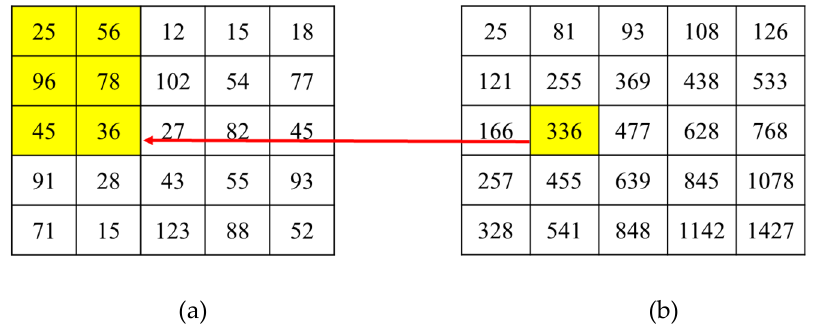
Figure 4. Steps for calculating the Integral image.